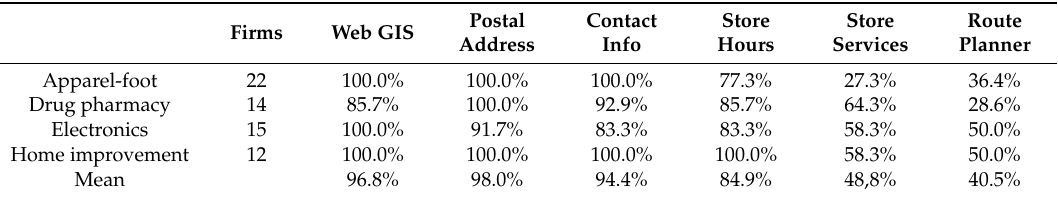
Table 1. Summary of information provided by general merchandise retailers, according to the store format.